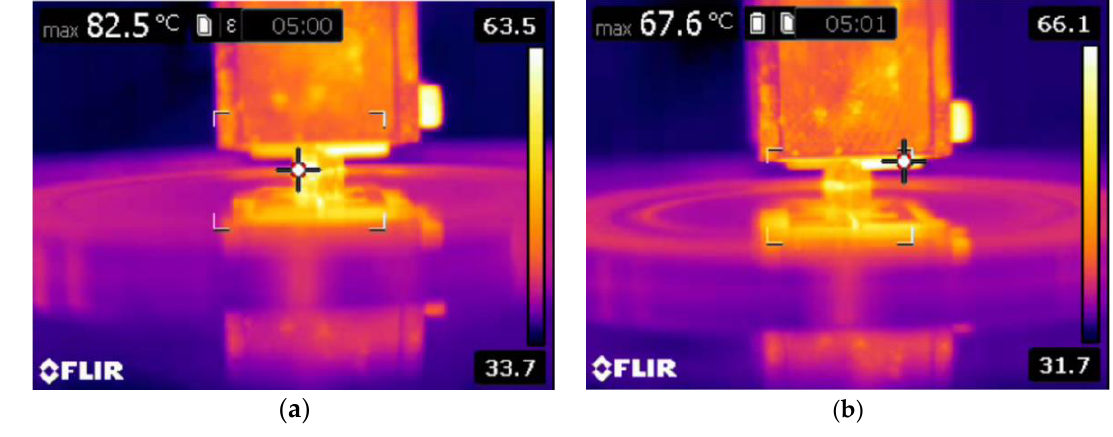
Figure 12. Worn surface morphology (SEM images) of the 10 wt.% composite: ( a ) 0.75 m/s, ( b ) 1.5 m/s, ( c ) 2.25 m/s.